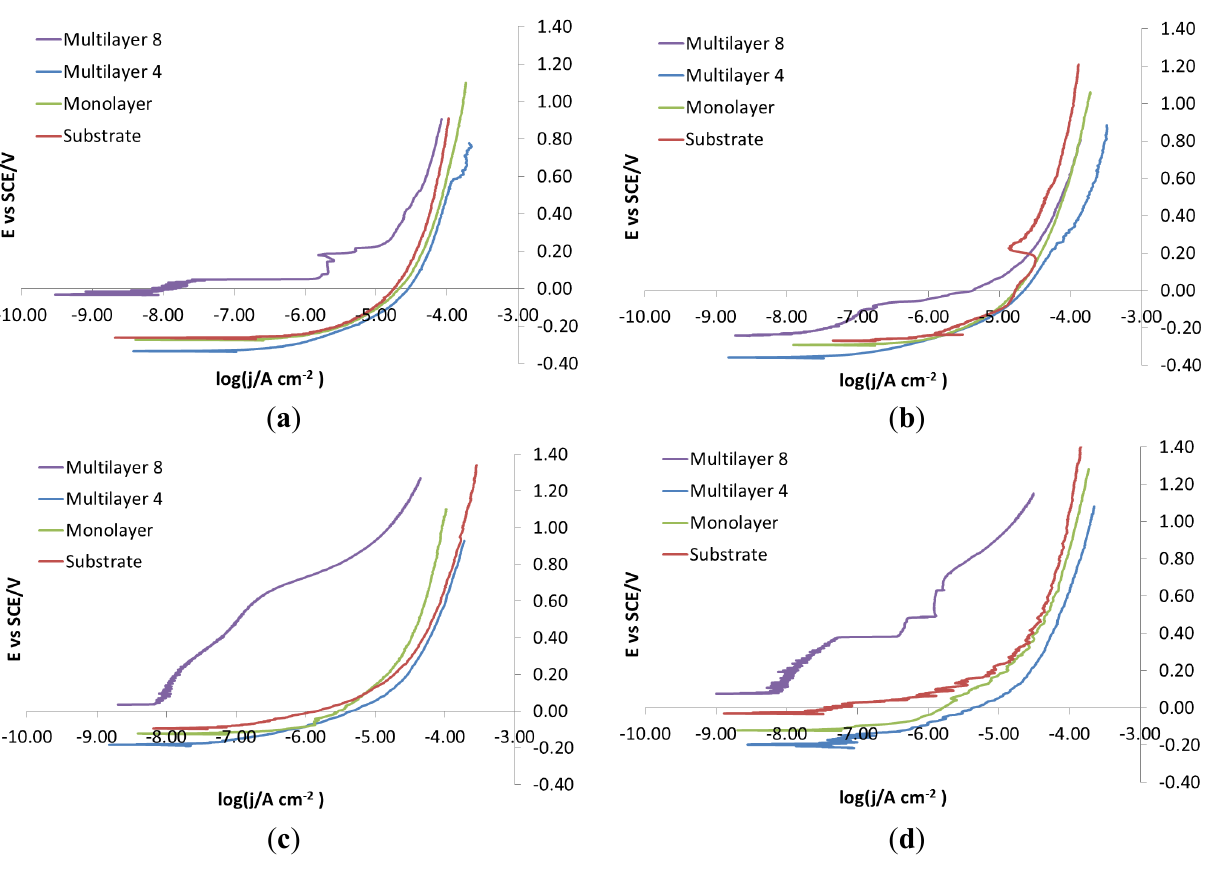
Figure 16. Sandblasted finish: polarization curves on bare and coated